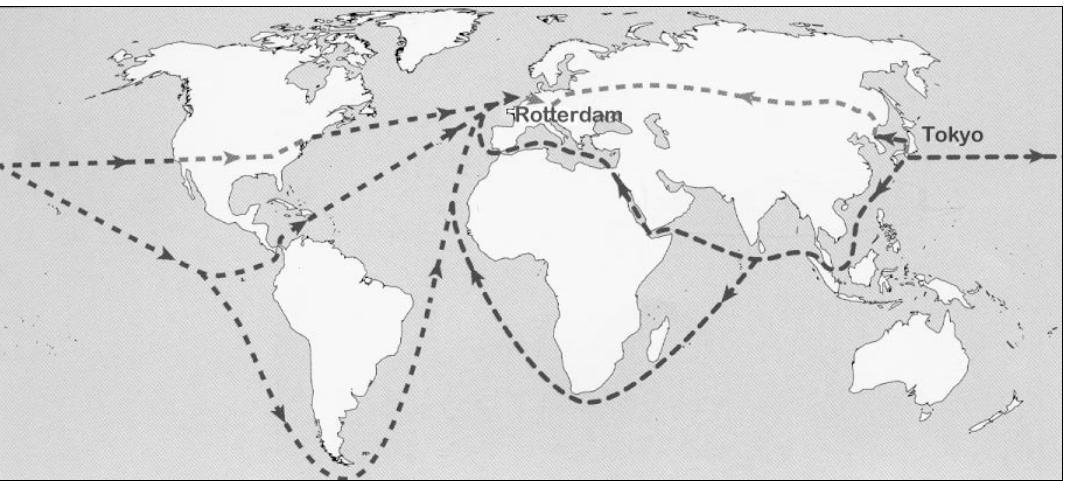
Figure 1. Example of container routes between Tokyo and